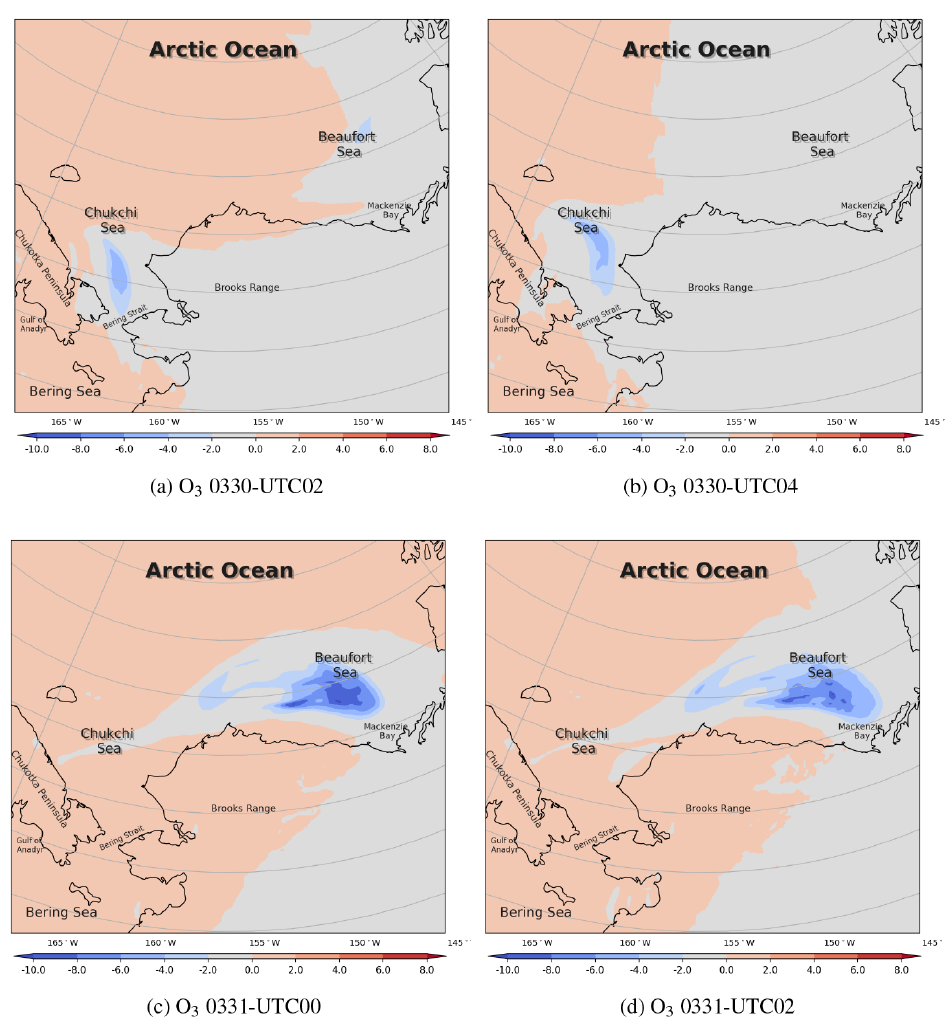
Figure 14. The change in surface ozone (ppb) caused by local chemistry, i.e., bromine chemistry, from 30 to 31 March 2019. The positive value represents a chemical production of ozone, while the negative value represents a chemical consumption of